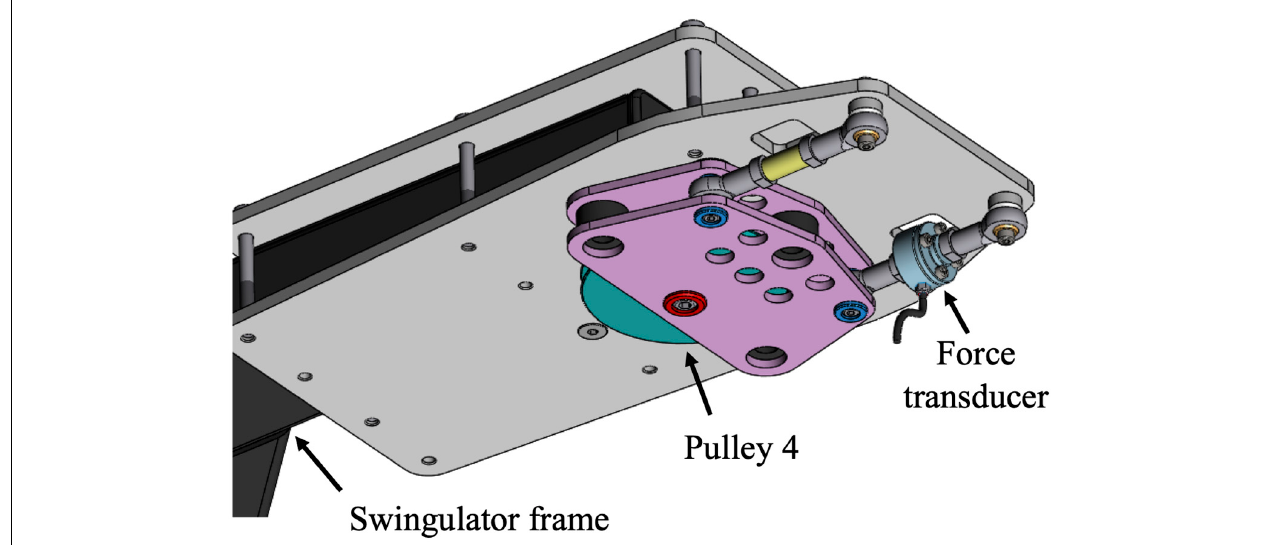
FIGURE 2 | Custom Swingulator attachment with force transducer at Pulley